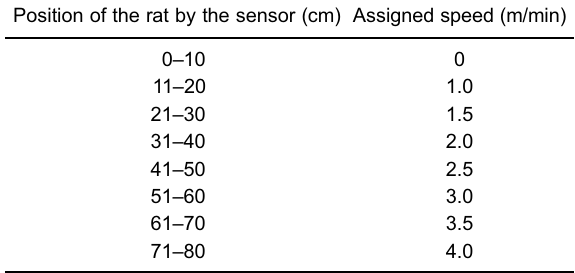
Table 2. Mapping between intervals and assigned speeds.